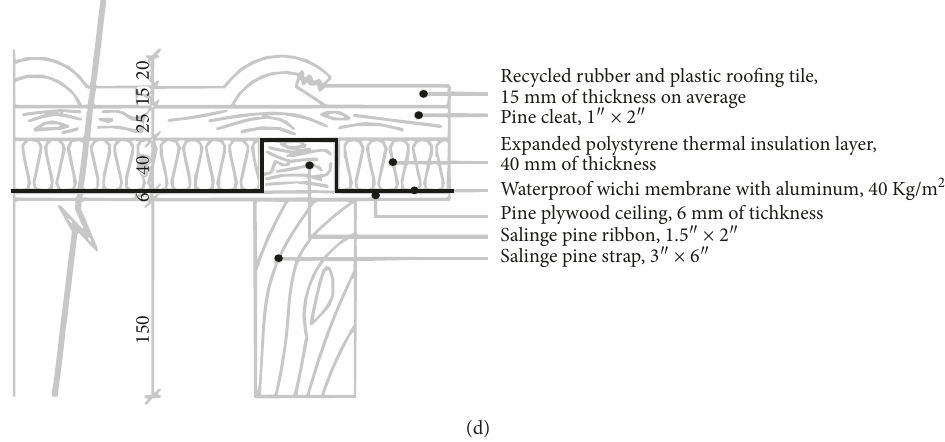
Figure 4: Constructive detail of case 1 (a), case 2 (b), case 3 (c), and case 4 (b).